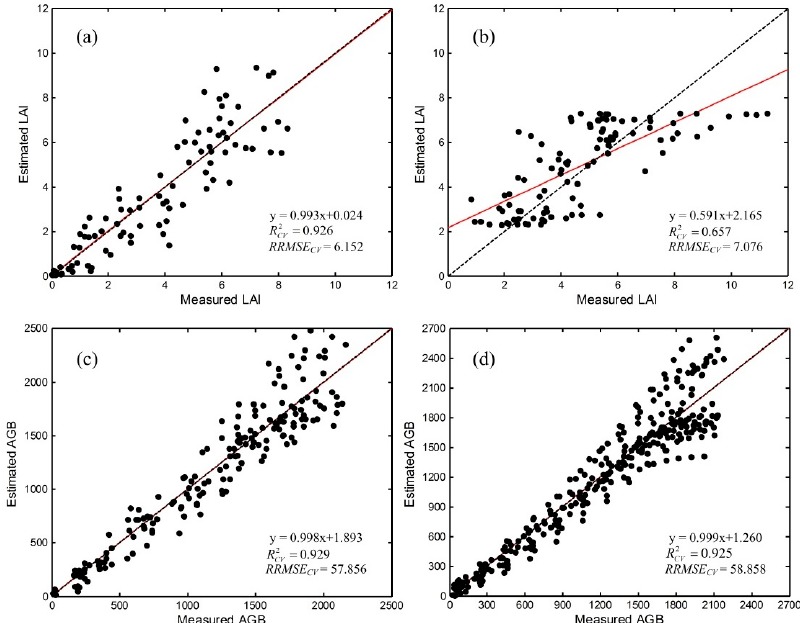
Figure 4. Relationships between measured rice leaf area index (m 2 /m 2 ) and dry aboveground biomass (g/m 2 ) at different rice growth stages with VIs. ( a ) Before heading LAI estimation using EVI2-BPNN regression; ( b ) after heading LAI estimation using NDVI-SVM regression; ( c ) all-growth stage AGB estimation using daily cumulative NDVI and based on the quadratic polynomial fit function; ( d ) all-growth stage AGB estimation using 10-day composite data and based on the cumulative NDVI quadratic polynomial fit function. The black dash lines are the 45° lines, and the red solid lines are the linear regression trend lines.